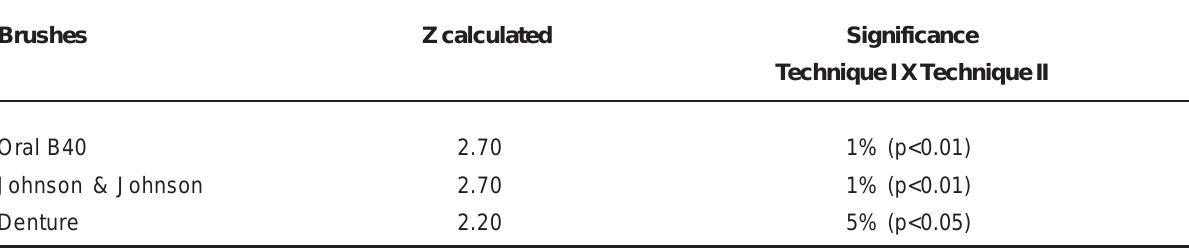
TABLE 2- Statistical difference (Wilcoxon test) between techniques I and II Brushes